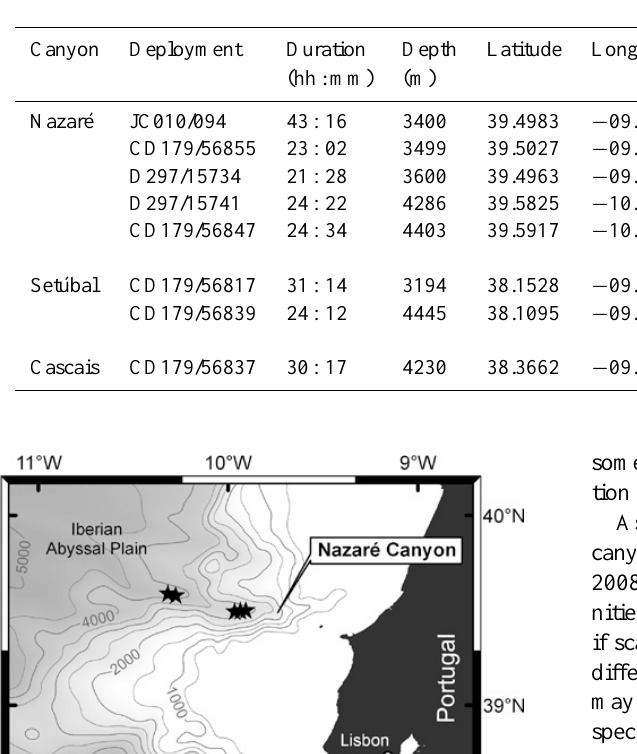
Table 1. Trap deployments made within the Iberian Margin submarine canyons during research expeditions RRS Discovery 297, RRS Charles Darwin 179, and RRS James Cook 010. 1 Data from CTD casts deployed in the vicinity ( < 2.5km radius) of each baited trap; 2 averaged data from Cunha et al. (2011).